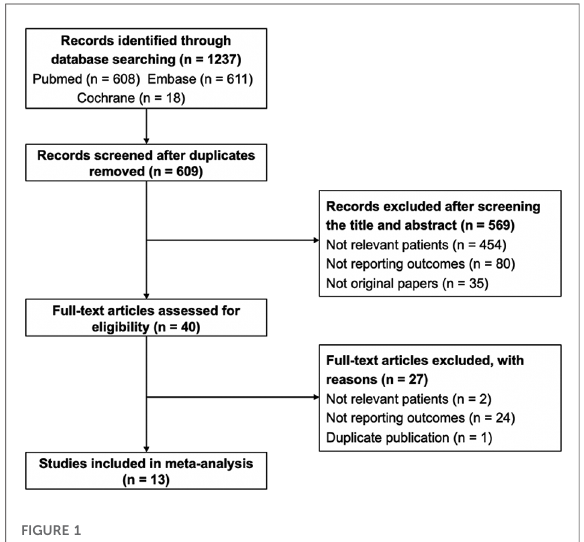
FIGURE 1 Flowchart of study selection